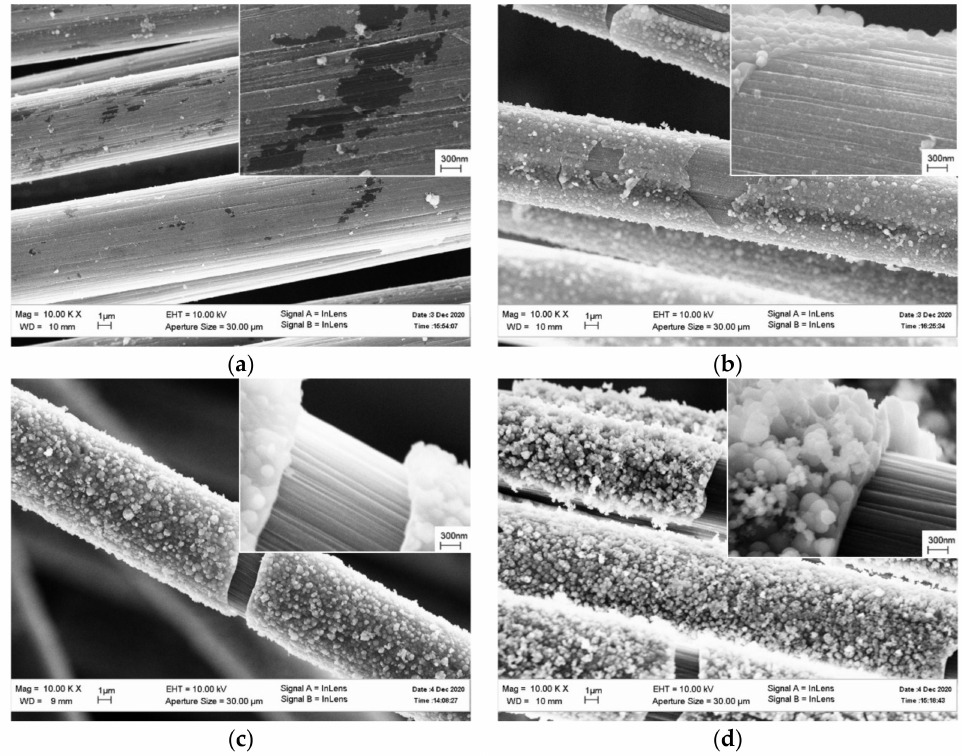
Figure 11. Surface of the coated carbon fiber formed at current density from 0.8 to 5.3 mA/cm 2 : ( a ) 0.8 mA/cm 2 , ( b ) 1.7 mA/cm 2 , ( c ) 2.6 mA/cm 2 , ( d ) 3.5 mA/cm 2